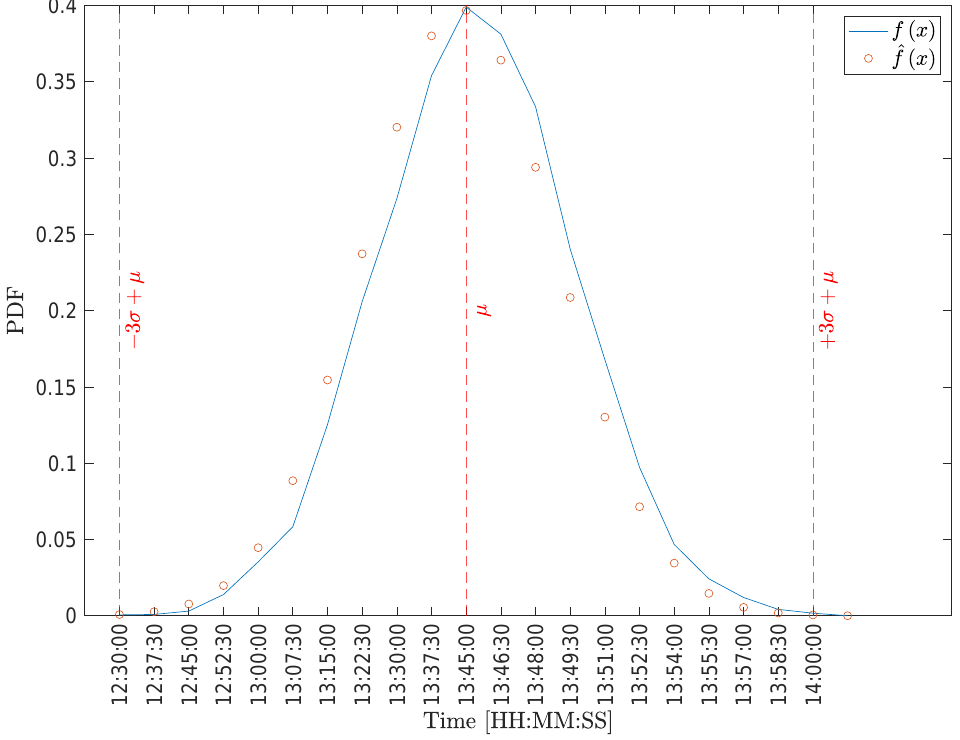
Figure 9. PDF f ( x ) and estimator PDF ˆ f k for the interval from 12:30 to 14:00. By conducting an analysis of f ( x ) and ˆ f k from Figure 9, it can be stated that the narrowing of the ranges (on the right) did not adversely affect the randomized values of the activation times of a given SA. SAs are usually run at 13:45 in the range ± 3 σ from − 3 σ = 12:30 until this time + 3 σ =